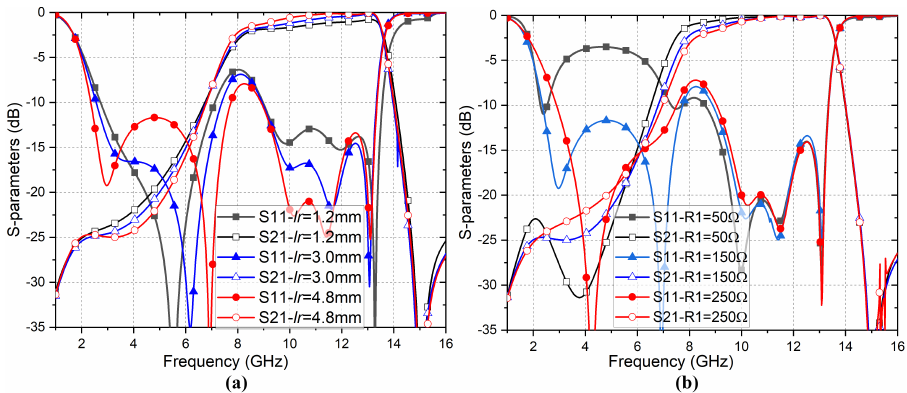
Figure 6. Parameterization optimization of FSR: ( a ) position of resistors (lr); ( b ) lumped resistor (R1).